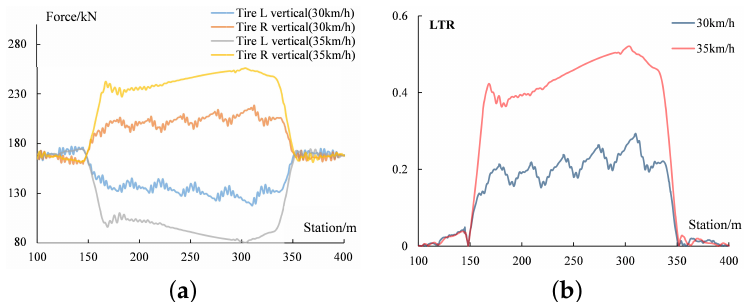
Figure 7. ( a ) Lateral vertical load distribution and ( b ) LTR value of the left and right tire for wind speeds of 68 km/h.